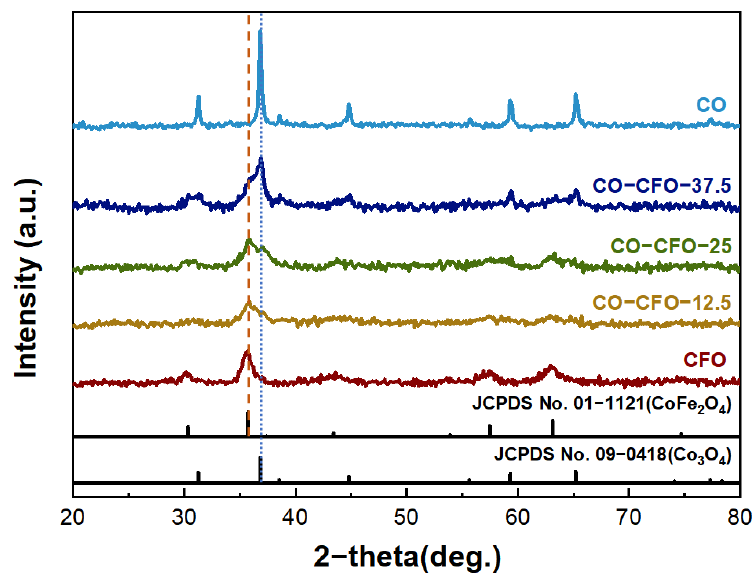
Figure 1. XRD patterns of spinel oxide CFO, CO-CFO-X, and CO.